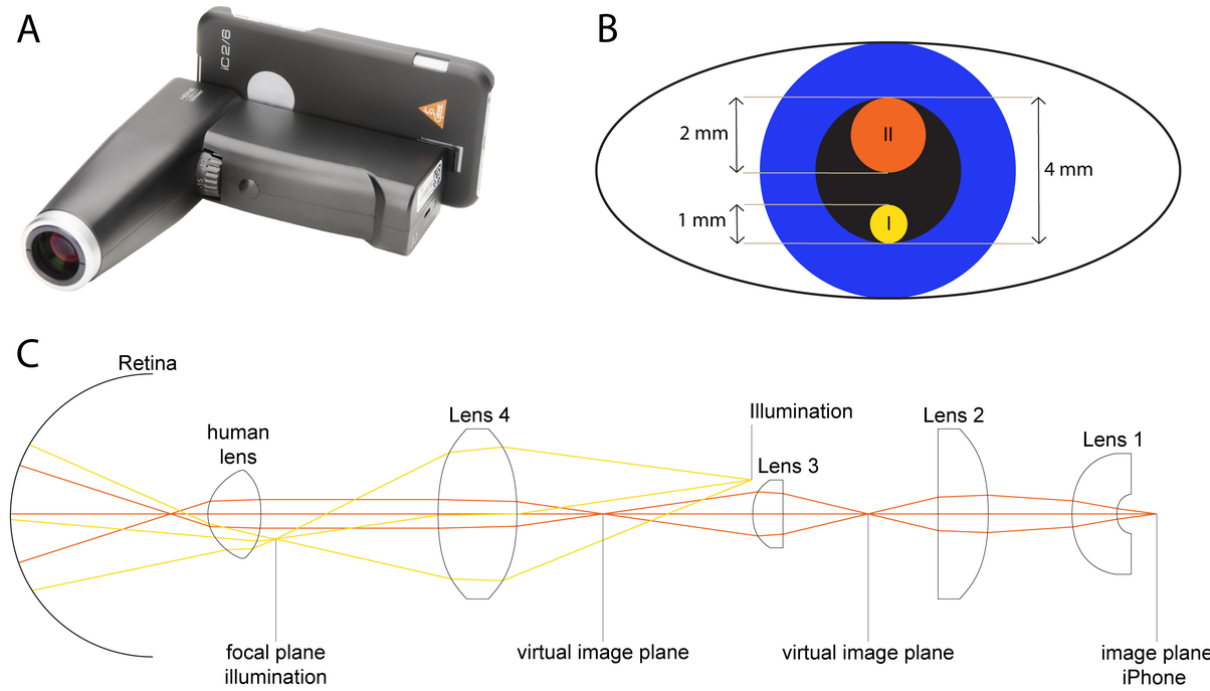
Figure 1. Optical setup of the smartphone-based funduscopy device evaluated in this study. The (A) smartphone-based fundus imaging device (iC2 funduscope; HEINE Optotechnik GmbH & Co. KG) evaluated in this study has a separate optical path for the illumination system and the imaging system. (B) Optical paths in the plane of the pupil (I=illumination’s light path, II=imaging system’s light path) with approximate scale. (C) The optical setup consists of four aspheric lenses and a polarized illumination source with a 3000-K light-emitting diode. The device allows for a field-of-view of up to 34 °. Lens 3 is adjustable for compensations of refractions up to ±15